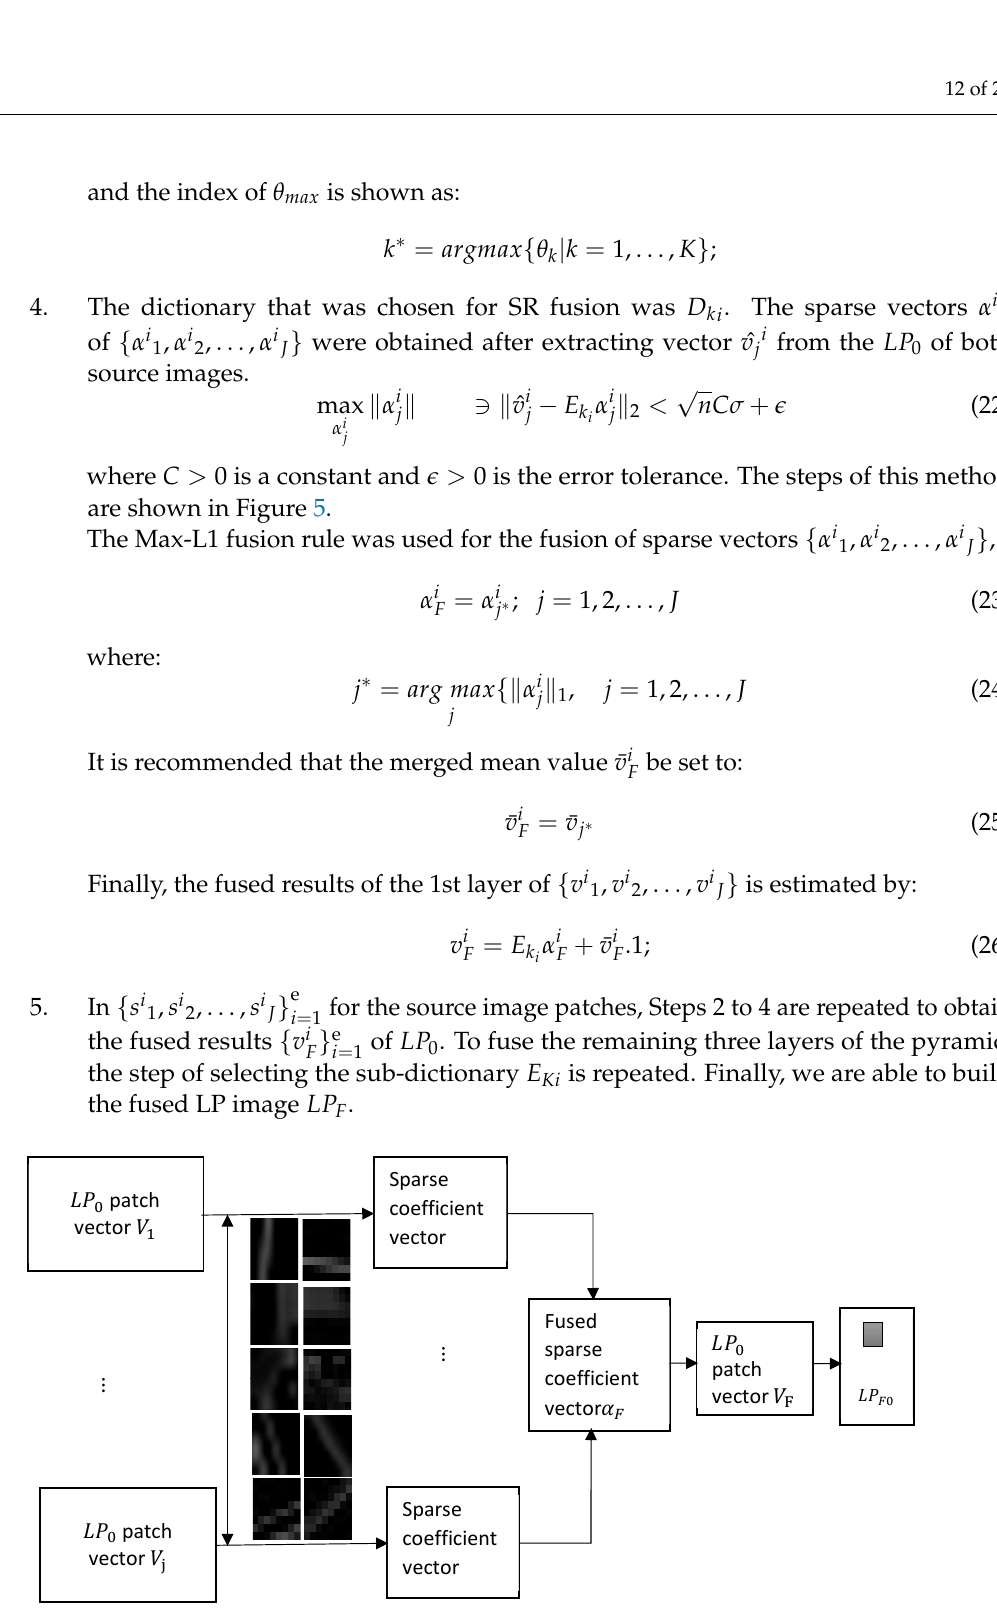
Figure 5. LP sparse vector fusion